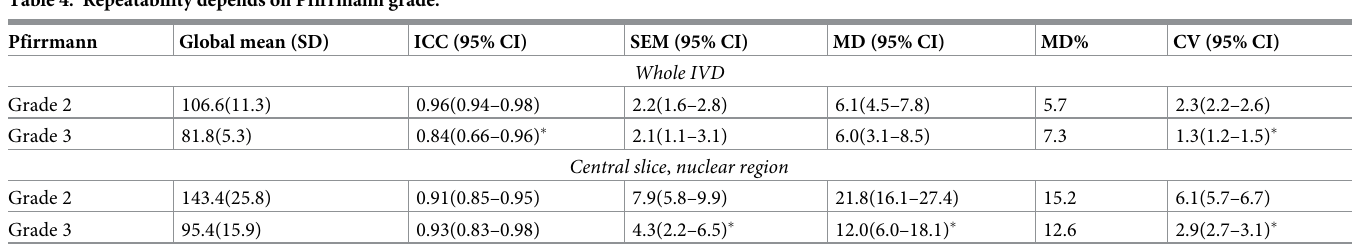
Table 4. Repeatability depends on Pfirrmann grade.